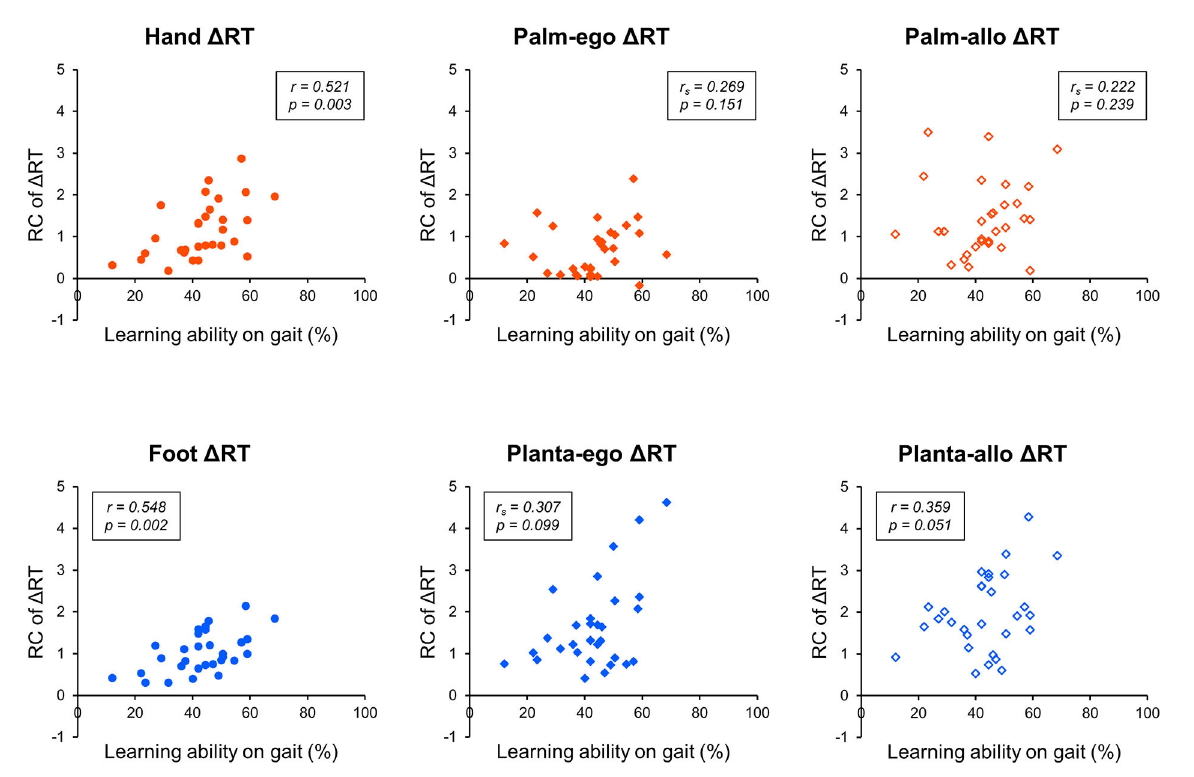
FIGURE7 Scattergram representing the correlation between the RC of 1 RT and adaptive motor learning ability on gait. The x-axis denotes the learning ability on gait evaluated by the split-belt treadmill walking task. The y-axis denotes the rate of change (RC) of response time ( 1 RT) measured by the mental rotation